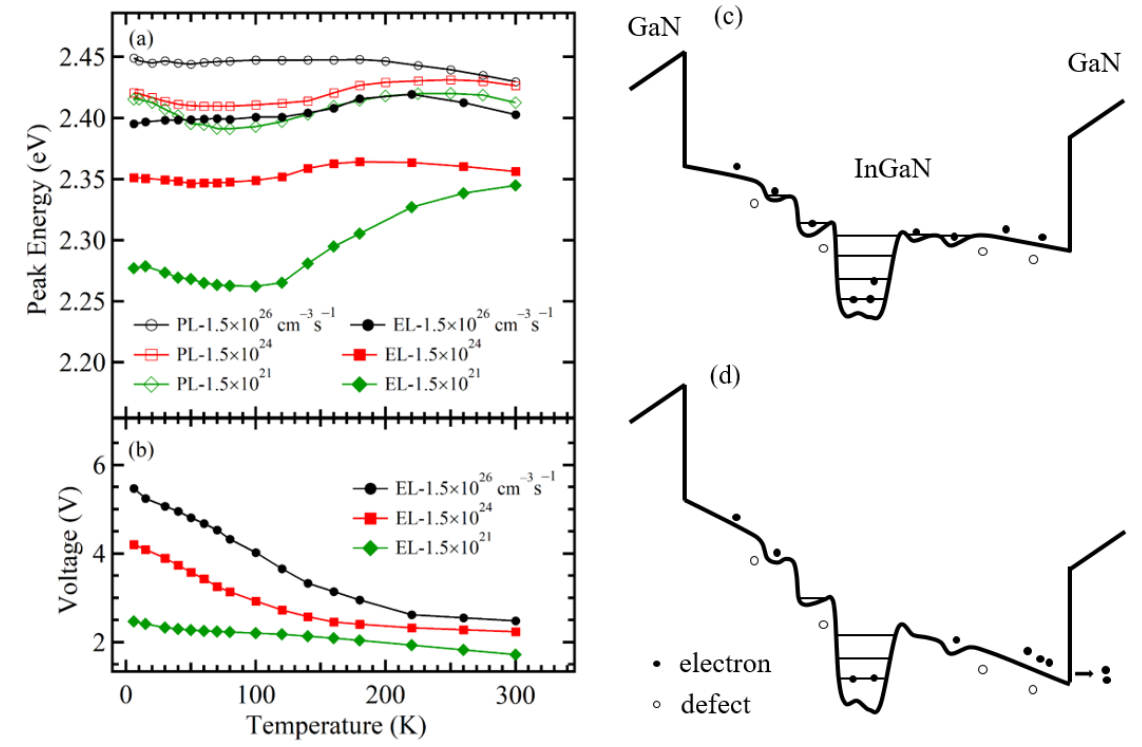
Figure 4. ( a ) Temperature dependencies of the PL-405 and EL peak energies for the green LEDs. ( b ) Temperature dependencies of the voltage at various current magnitudes. Schematic diagrams of a single QW indicating the possible mechanism of carrier transfer and distribution under excitation by 405-laser ( c ), and current ( d